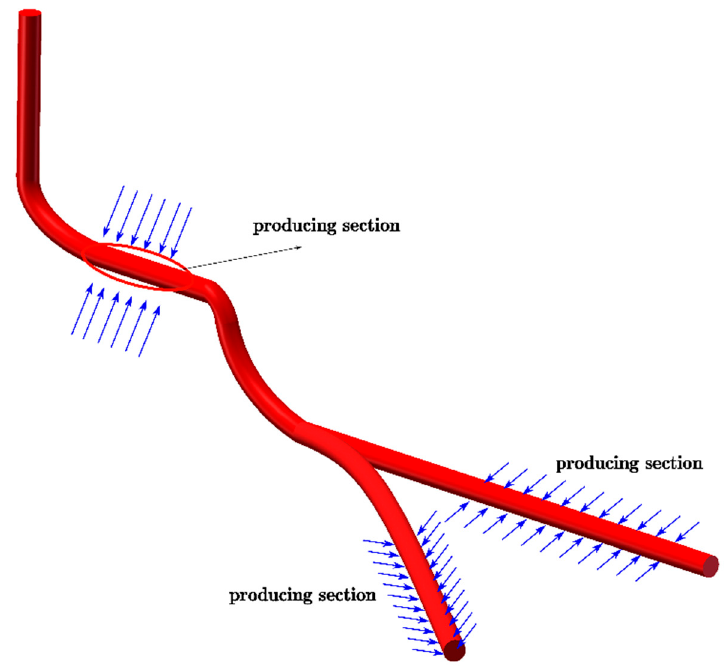
Figure 1. Definition of producing section. Figure 1. De fi nition of producing section.